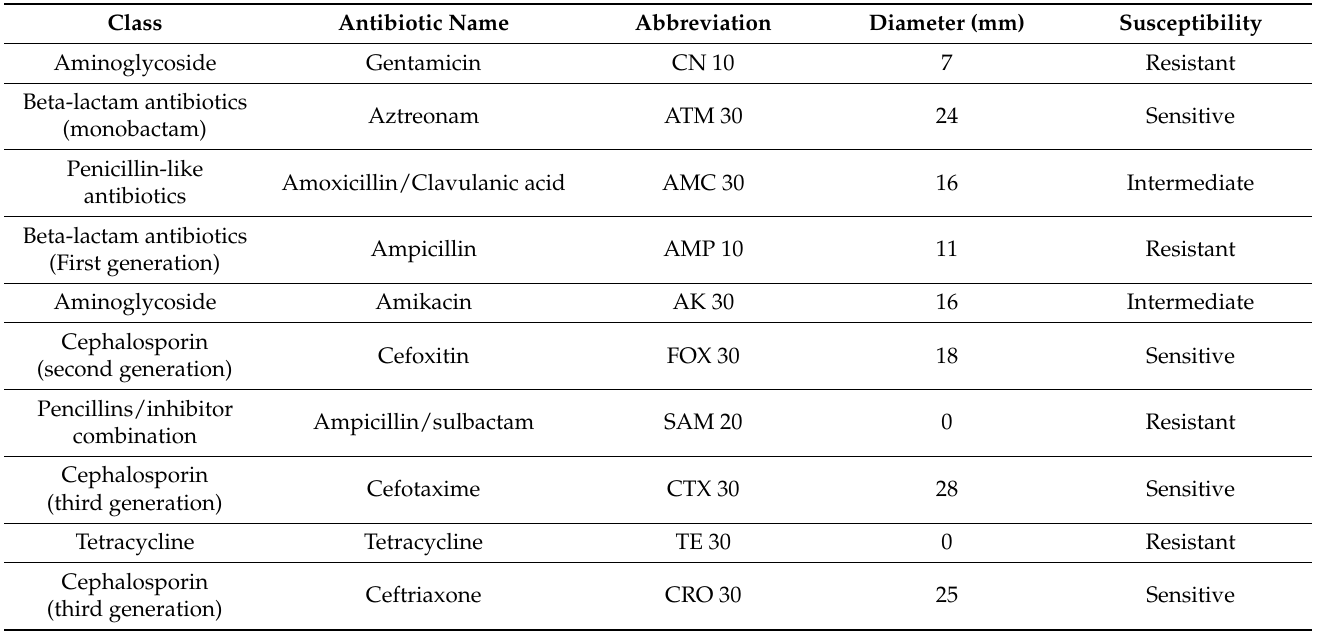
Table 1. Phenotypic sensitivity of E. coli O18 strain to ten different